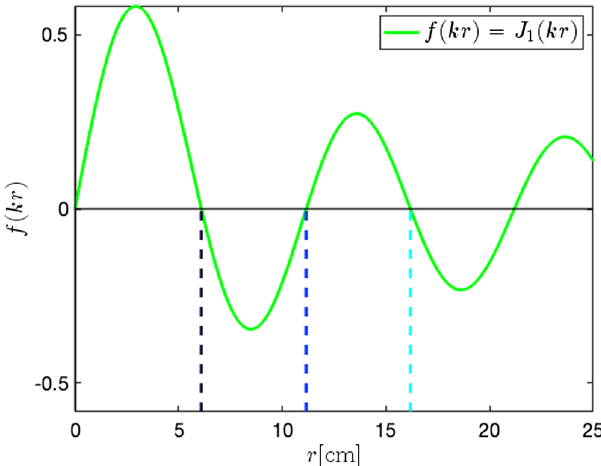
FIG. 1. J 1 ð kr Þ plotted against r with k ¼ 2 π × 3 GHz = c. The black, blue, and cyan dashed lines show three points of intersection with the r